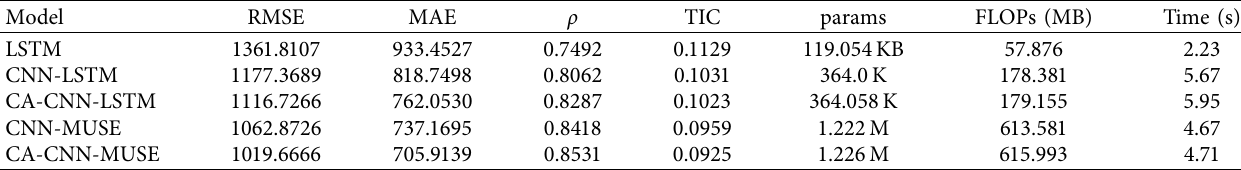
Table 1: Performance of diferent models.